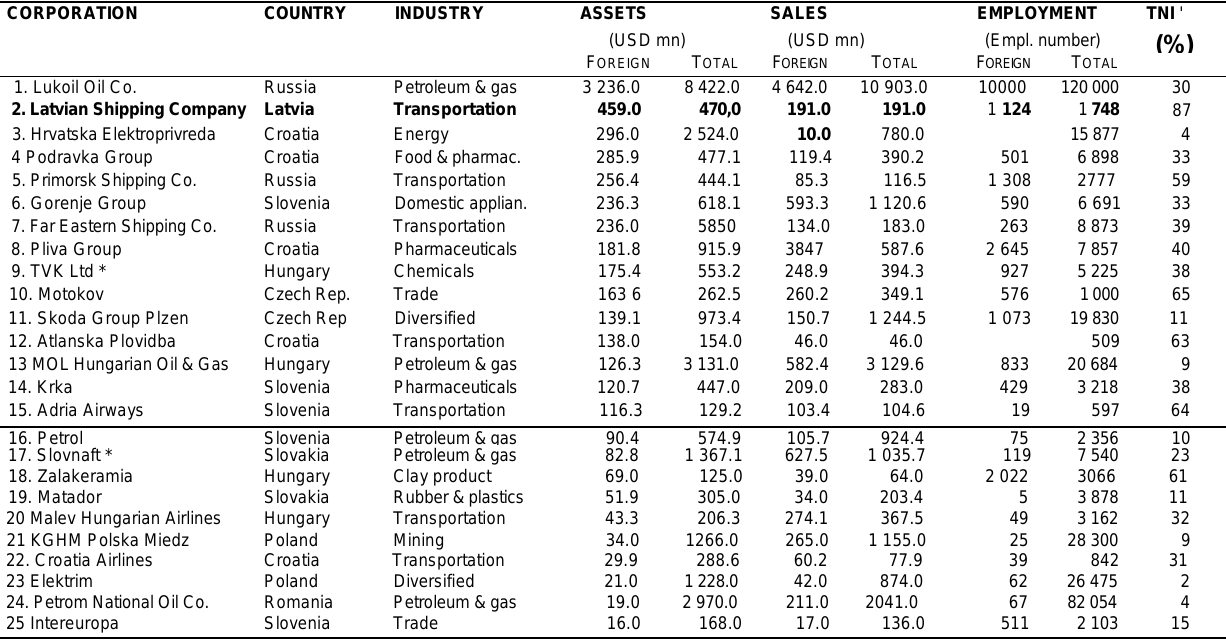
Table 1. Top 25 Non-Financial Transnational Corporation based in Central Eastern Europe (ranked by foreign assets, 1999). Source: [12]